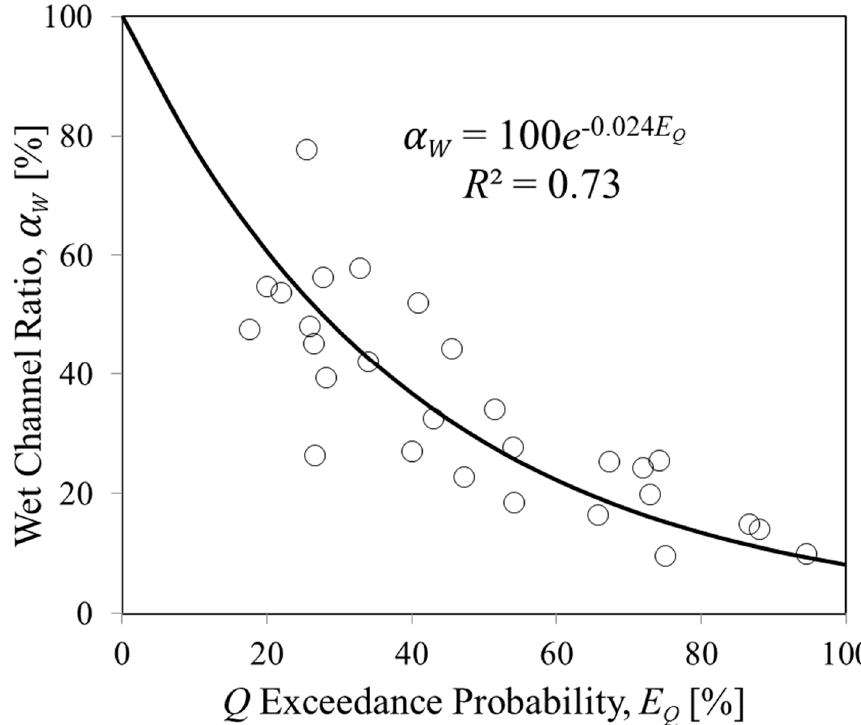
Figure 6. The relationship between streamflow exceedance probability ( E Q ) and the wet channel ratio ( α W ) in the study